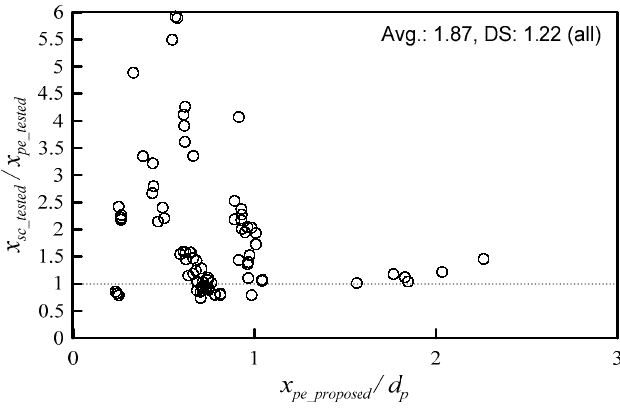
Figure 7. Ratio of tested-to-predicted scabbing depth.